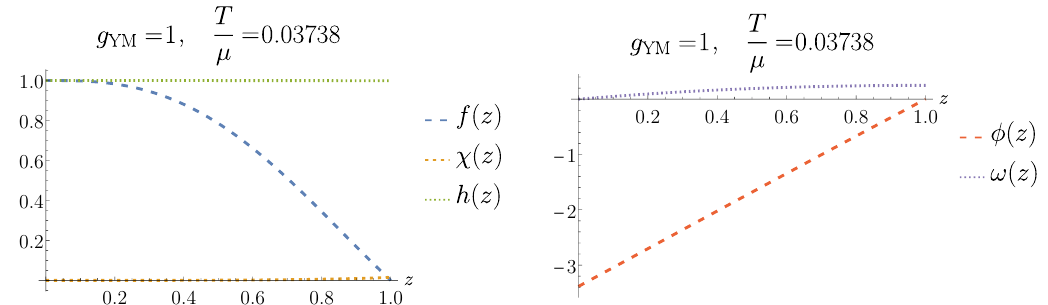
Figure 1. Plots of the matter and metric functions, for T/µ = 0 . 03738 and g YM = 1 . The functions take on a simplified form close to critical temperature T c /µ ≈ 0 . 03748 . φ ( z ) becomes approximately linear, χ ( z ) ≈ 0 and h ( z ) ≈ 1 , while ω ( z ) is small and f ( z ) has polynomial behaviour. When the temperature is raised above its critical value, the phase changes from superconducting to normal and the Reissner-Nordström geometry is